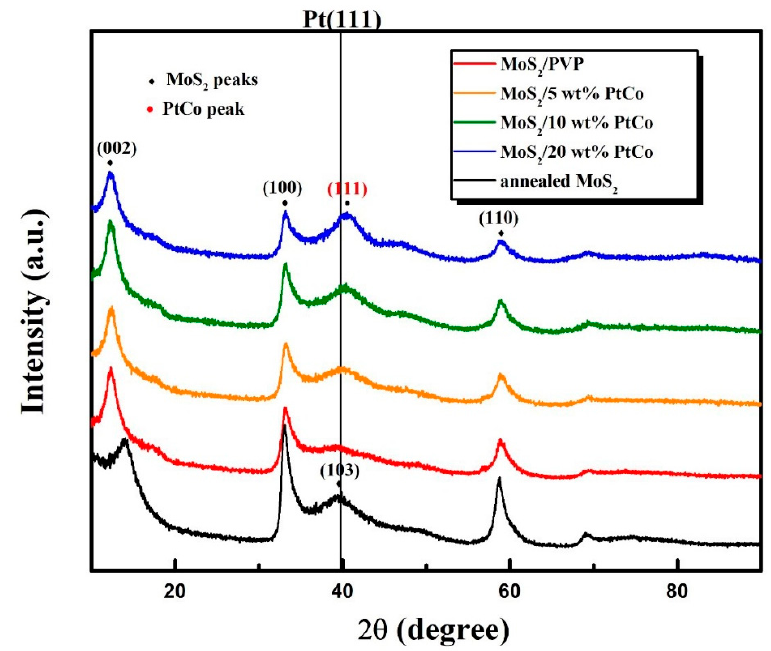
Figure 1. XRD patterns of MoS 2 microspheres and MoS 2 / PtCo-alloy nanoparticle (NPs) composites.